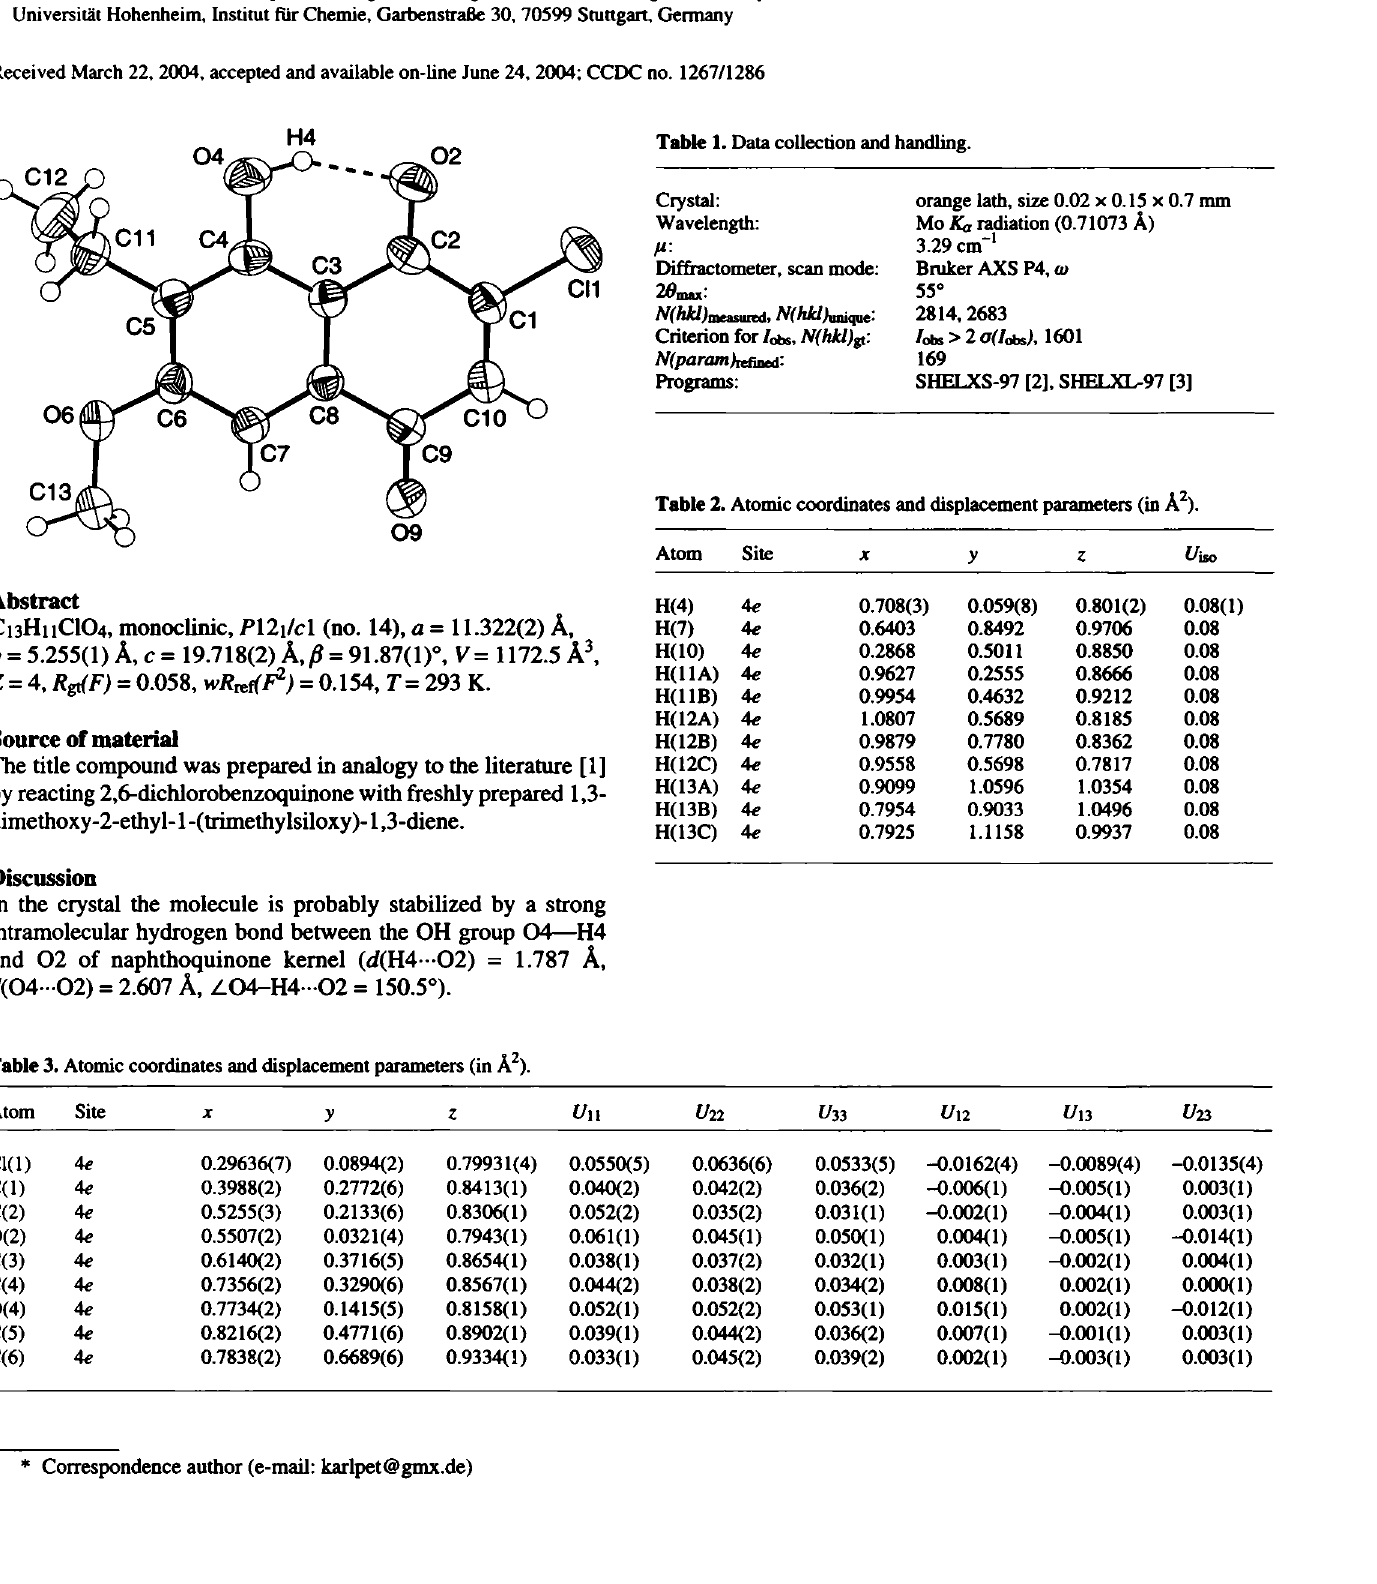
Table 1. Data collection and handling.